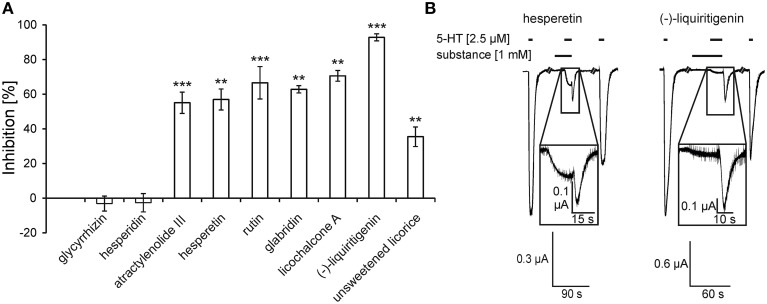
5-HT3A receptor inhibition by the substances and the unsweetened licorice tincture (A) and original traces of the antagonistic effect of hesperetin and (-)-liquiritigenin (B). (A) Of the tested substances, the flavonoids exhibited the strongest inhibition with hesperetin and rutin from Aurantii and licochalcone A and (-)-liquiritigenin from Glycyrrhiza species. The inhibition from left to right are the following: −3.1 ± 4.3%, −2.6 ± 5.3%, 55.0 ± 6.2%, 57.0 ± 6.1%, 66.6 ± 9.3%, 62.8 ± 2.1%, 70.6 ± 3.1%, 92.8 ± 2.0%, and 35.5 ± 5.7% (n = 5 − 9) [tincture = 1 Vol.-%, substances = 1 mM except glabridin (100 μM)] (**p < 0.005; ***p < 0.0005). (B) The time of application is denoted by the application bars above the traces. The inhibition was reversible after a 150-s washout. The 5-HT-induced currents showed a characteristic rebound when co-applied with hesperetin or (-)-liquiritigenin (magnifications).